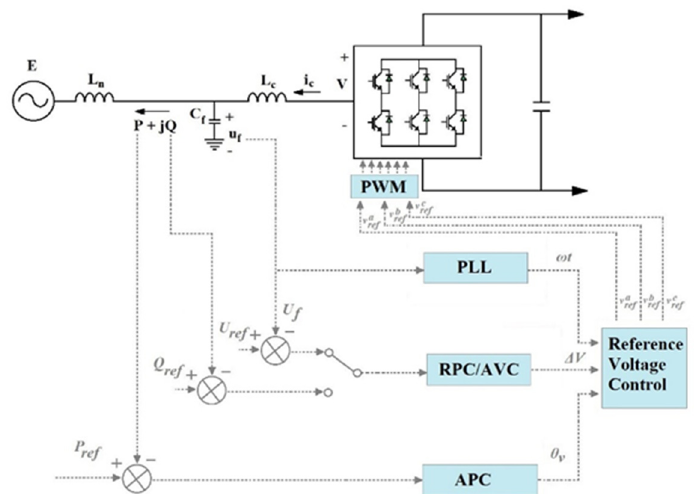
Figure 13. VSC-HVDC “power angle” control strategy.